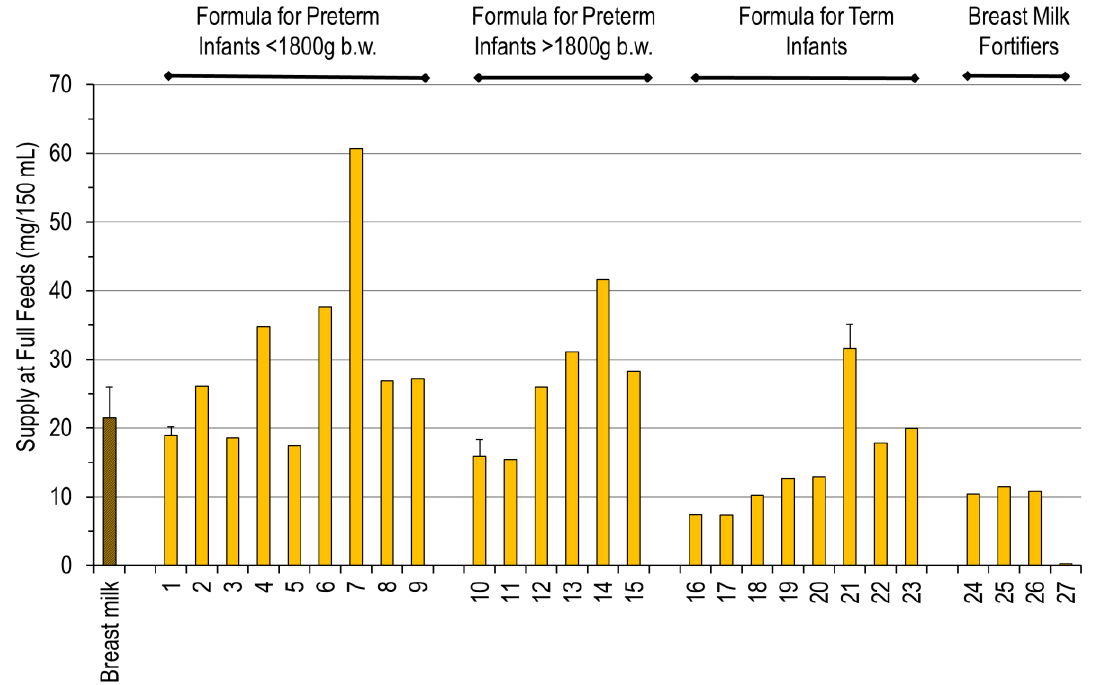
Figure 2. Daily Intake of Total Choline by Infants at Full Feeds. Products are grouped according to the target groups as “Formula for Preterm Infants” below or above 1800 g body weight (b.w.), “Formula for Term Infants”, and “Breast Milk Fortifiers” for preterm infants. Individual product numbering is indicated in Table 1. Data are mean and standard deviations of breast milk from 21 mothers of preterm infants and a convenience sample of formulae from different producers. No standard deviation is provided if there was only one sample, several samples of a single batch, or less than three different batched available for analysis.